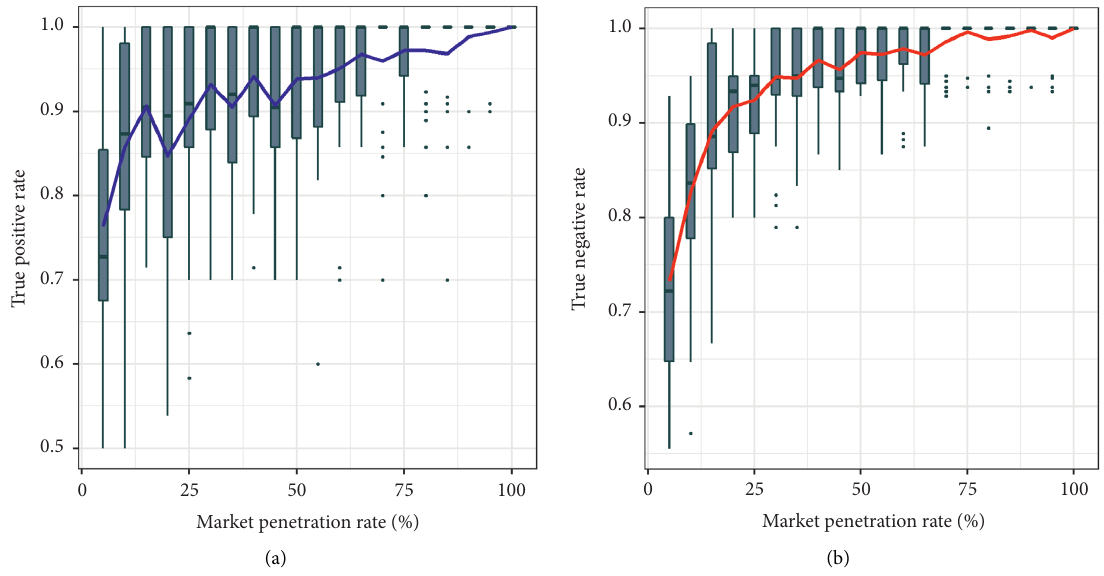
Figure 6: Results of data divergence detection (0.3 of DDI threshold). (a) TP rates at different MPRs. (b) TN rates at different